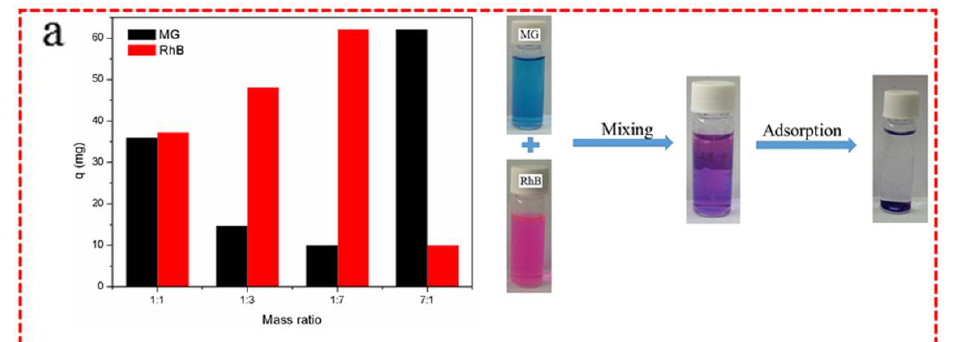
Figure 4. Adsorption isotherm models of MSNs for adsorption of cationic dyes with the Langmuir model ( a ), Freundlich model ( b ), and plot of adsorption capacity ( q e ) vs equilibrium concentration of MSNs for adsorption of cationic dyes according to the Langmuir model ( c